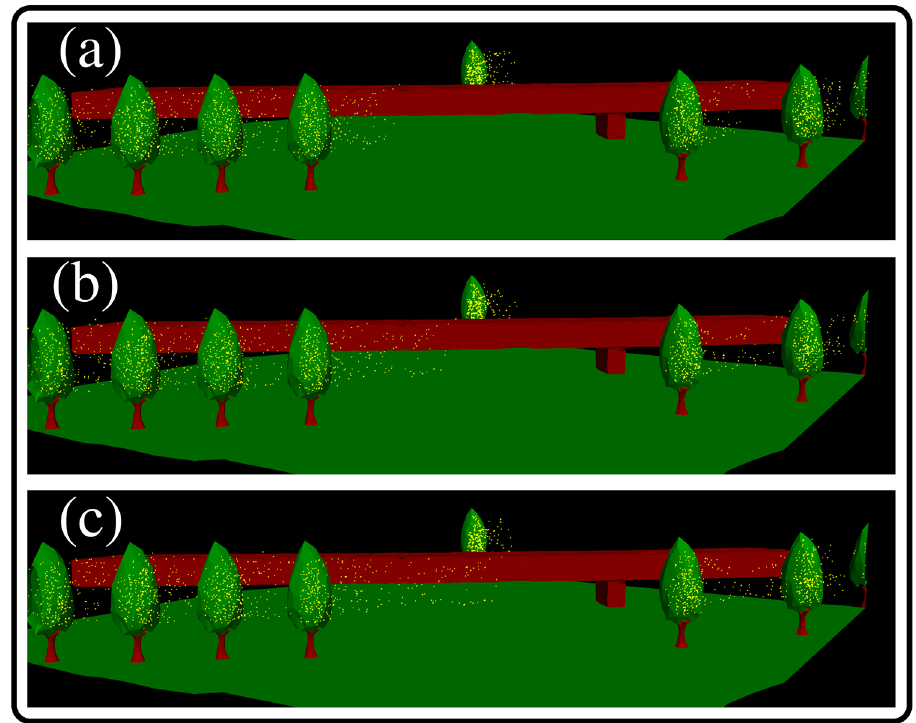
Figure 6. Pollen transport in a region R inside the university campus showing grains-trees detachment due to the wind-tree-leaves interactions. ( a ) t = 1 s; ( b ) t = 2 s; ( c ) t = 3 s. Computational case of the weather conditions on 06/04/2020 with a total initial number of pollen grains n max ≈ 0.4 × 10 6 . A local region R of the whole domain corresponds to a box of dimensions: L = W = 100 m and H = 40 m (see “Methods” section). For the complete aerodynamics at all time steps, see the multimedia video file: Video 4.